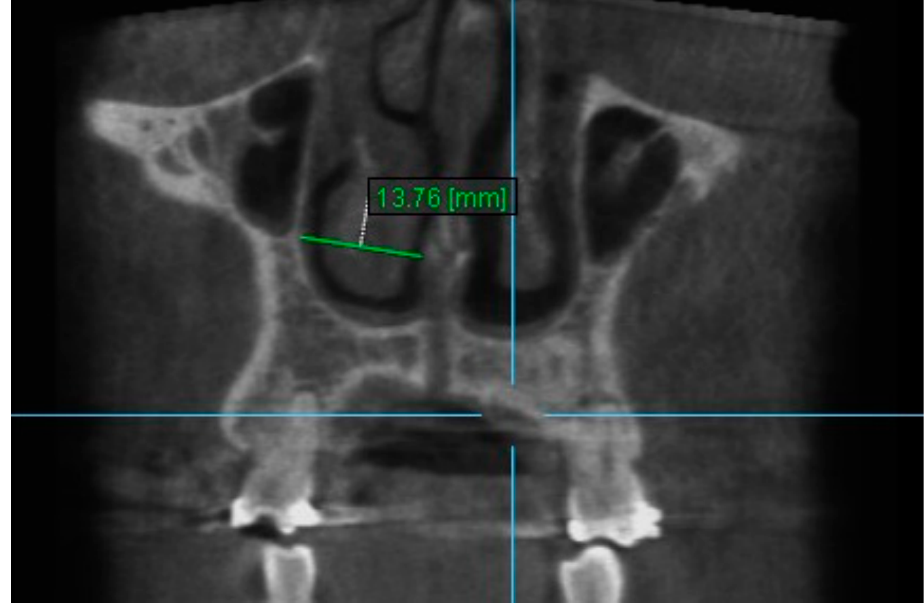
Figure 6. Nasal Width 4. 5. Nasal Width 5: The maximum distance between the inner left surface of nasal cavity and nasal septum on coronal slice through the center of mesial buccal root of the first premolar (Figure 7).